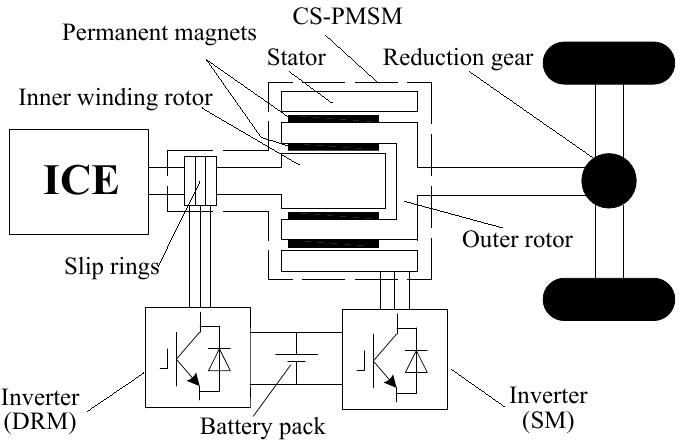
Figure 1. Hybrid electric system based on